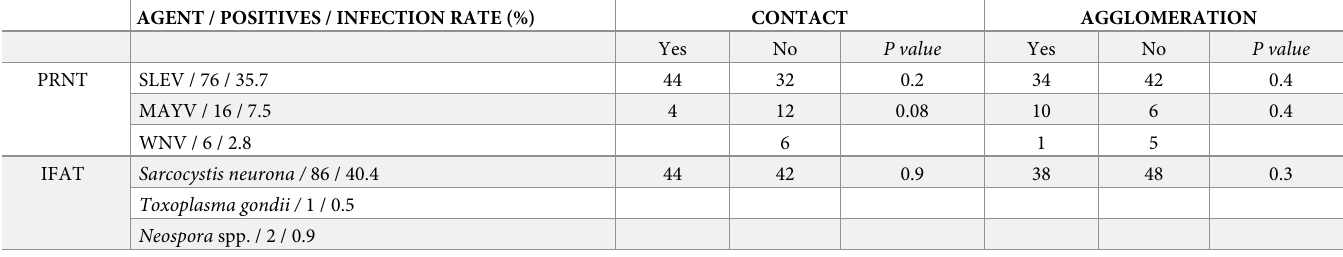
Table 1. Results of the PRNT 90 for viruses and IFAT for protozoans in horses (n = 213) from Roraima state, Brazilian Amazon. AGENT / POSITIVES / INFECTION RATE (%) CONTACT AGGLOMERATION Yes No P value Yes No P value